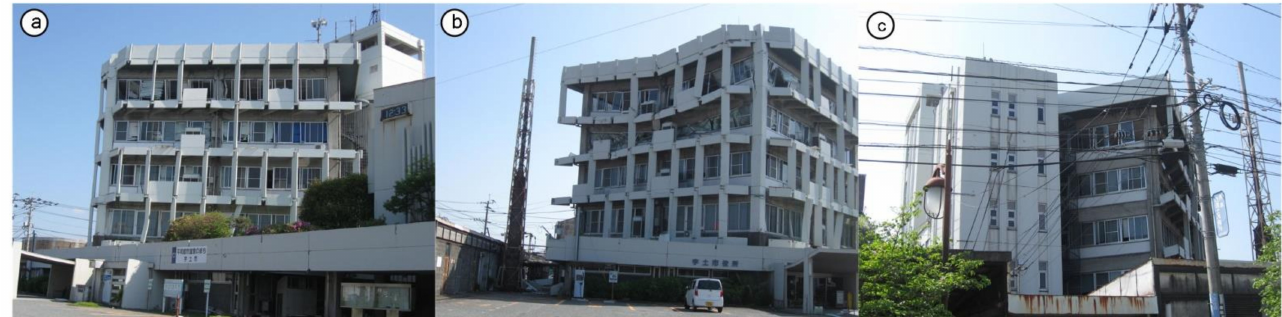
Figure 5. View of the former Uto City Hall after the 2016 Kumamoto earthquake [44]. Photographs were taken from ( a ) the south, ( b ) the southwest, and ( c ) the north.